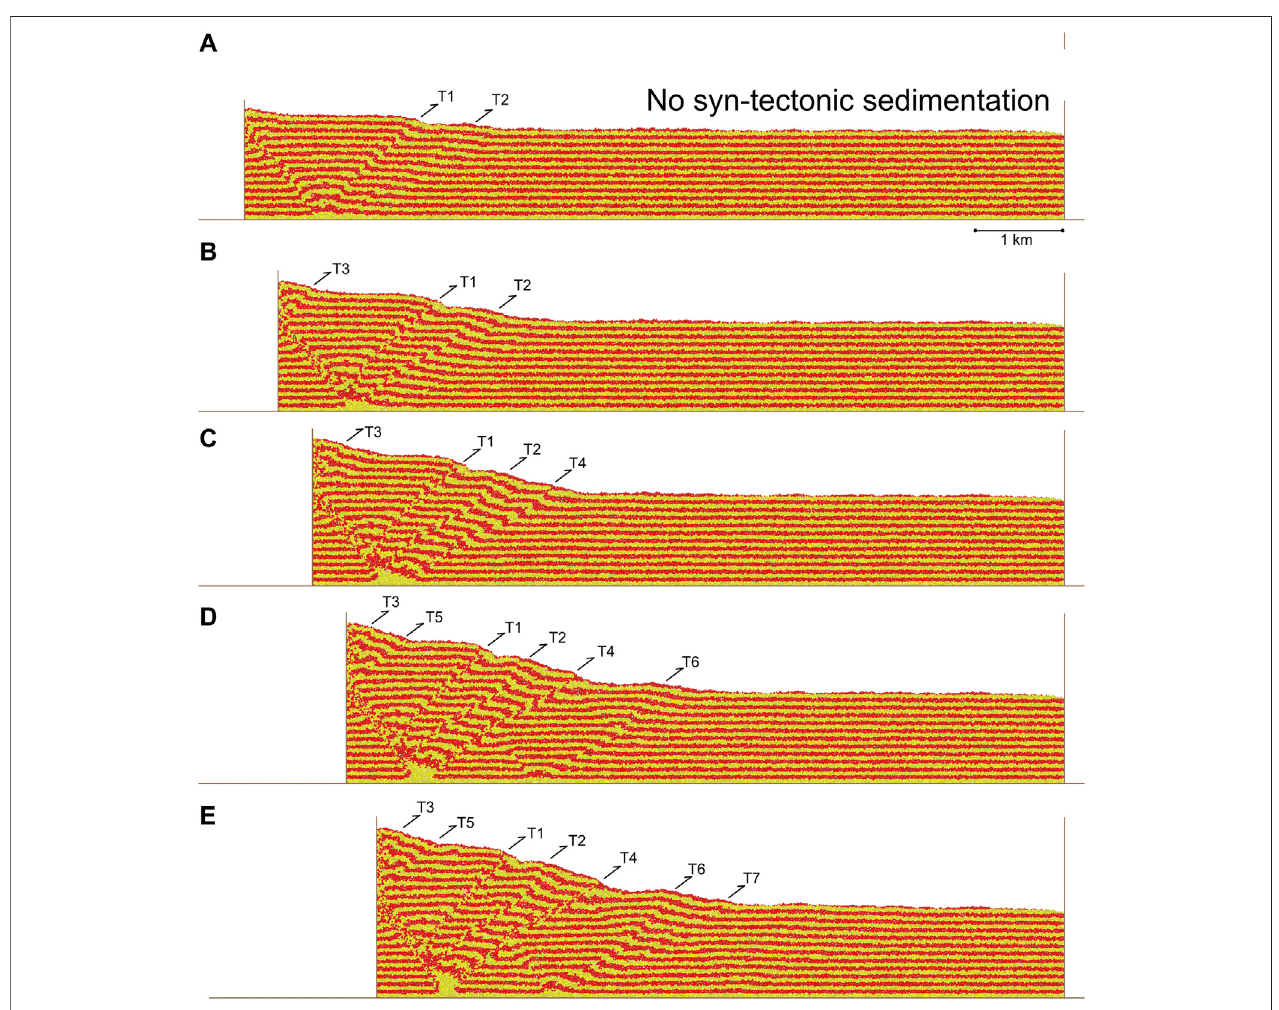
FIGURE 2 | Experiment 1, progressive evolution of a contractional model with “ no ” syn-tectonic sedimentation. Results are shown after 500 (4%), 1,000 (8%), 1,500 (12%), 2000 (16%), and 2,500 (20%) m contraction/displacement on the left-hand end-wall, see text for discussion.